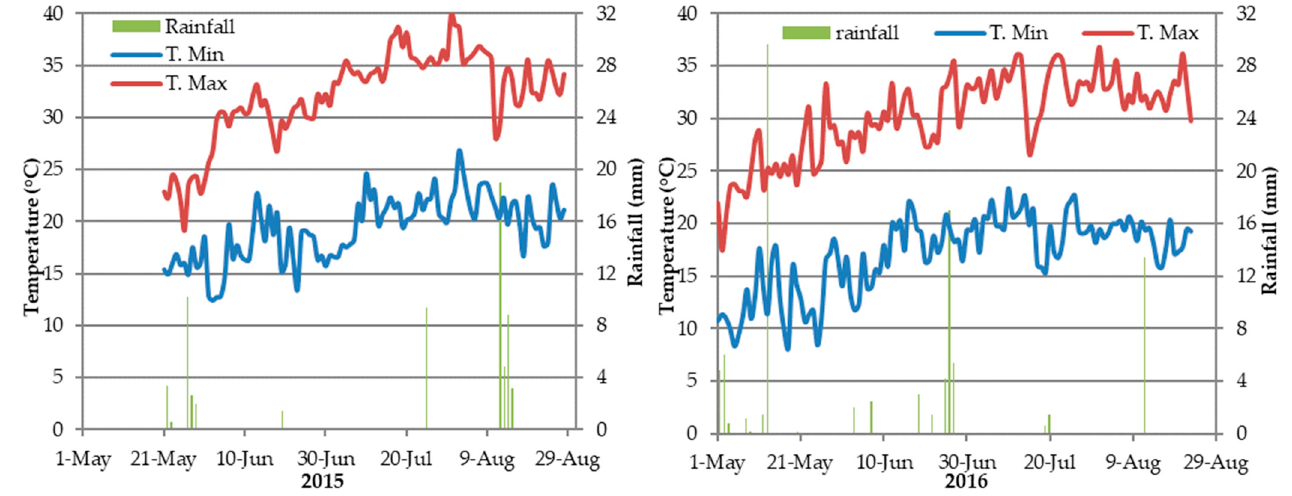
Figure 1. Daily average maximum and minimum temperatures and rainfall during the trial periods.